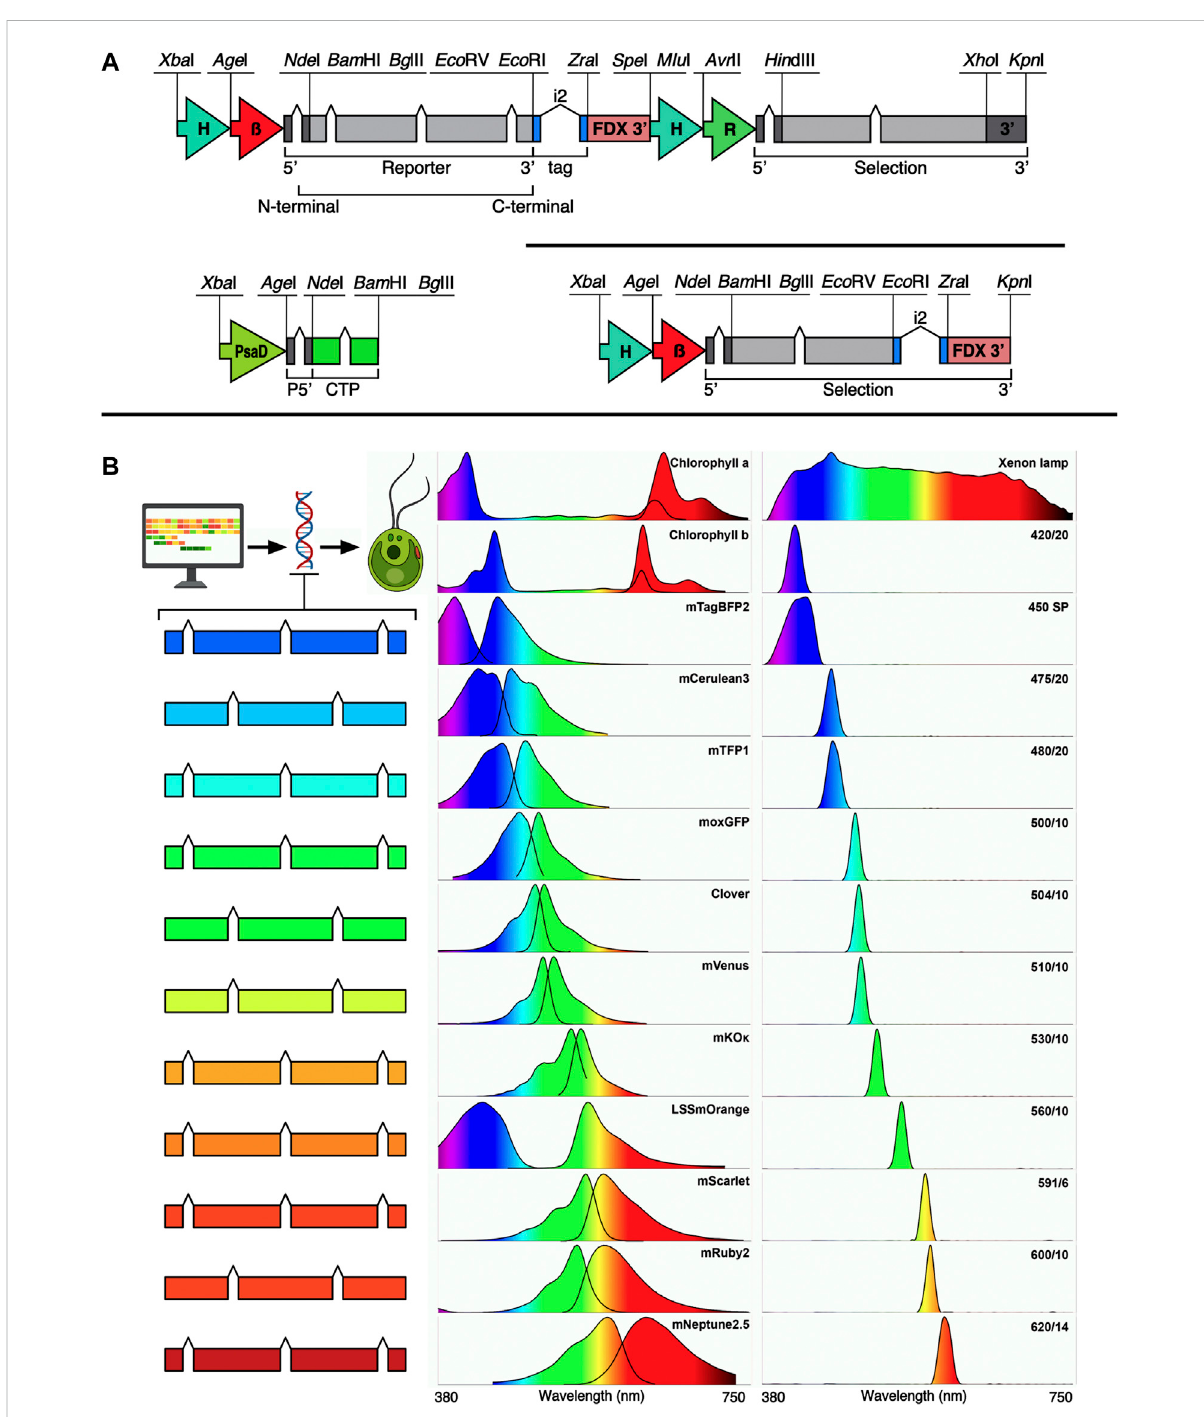
FIGURE 1 pOptimized 3.0 plasmid design, new fl uorescent reporters, spectral properties and fi lters used in this work. (A) Design of the pOpt3 plasmids is shown:allintentionalrestrictionenzymesarelabelled,H- β — combinedHSP70Abetatubulinpromoterandits5 ’ untranslatedregion(5 ’ UTR)(Einhaus et al., 2021). FDX 3 ’– 3 ’ UTR of the ferredoxin 1 gene (Einhaus et al., 2021). Chevrons indicate placement of the RBCS2 intron 1, i2 — indicates placement of the RBCS2 intron 2 inside coding regions for epitope tags. The selection marker cassette of the binary plasmid contains H-R — HSP70A-rbcs2 promoter and rbcs2 terminator (Wichmann et al., 2018). PsaD — photosystem I reaction center subunit II promoter with 5 ’ UTR containing and rbcs2i1 and its own chloroplast targeting peptide (CTP). Each element is separated by a unique restriction endonuclease site as indicated. (B) Left — fl uorescentreportersoptimizedfor C.reinhardtii nucleartransgeneareshownincolorcodedcartoons representing thenumber of RBCSi1 each contains. Center panel — the excitation emission spectra for each corresponding FP and chlorophyll a + b (data from FPbase.org). Rightpanel — therelativetransmittance(peak/bandpassnm)ofeach fi lterusedinthisworkmeasuredwithaspectrometer.Thelightsourceusedwas a xenon lamp with broad emission spectrum which is shown in the top